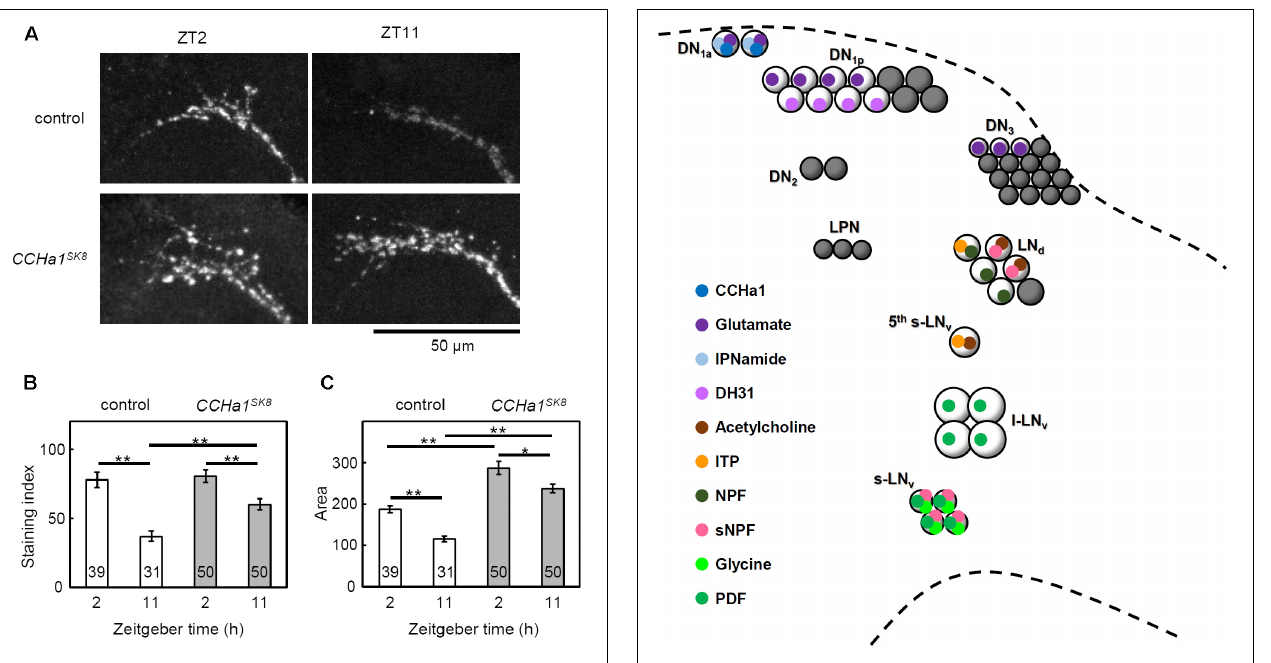
FIGURE 9 | A schematic model showing neurotransmitter content in clock neuron clusters. Circles representing neurotransmitters that are filled with black have not been identified yet. Glutamate and DH31 are expressed in the DN 1p neurons but it is not known whether they are co-localized. s-LN v terminal remodeling in CCHa1 SK8 mutants ( Figure 8